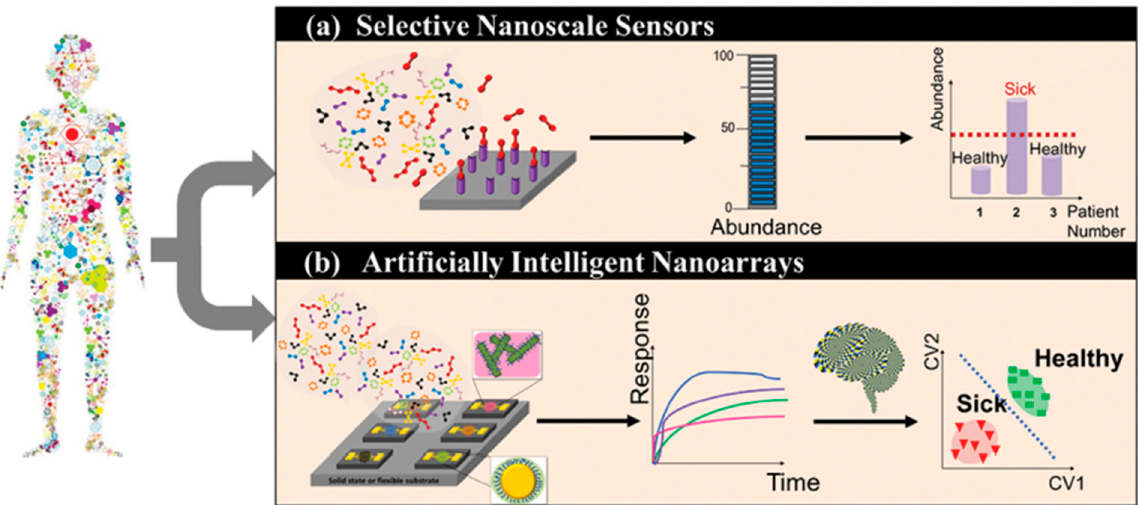
Figure 2. Schematic representation of the working principle of selective sensors and artificially intelligent cross-reactive sensor arrays. Selective sensors contain highly selective elements in order to detect a specific gas-analyte in the presence of a composite gas-mixture. Cross-reactive arrays feature sensors that are sensitive to the majority of the gases present in the gas-mixture. In any case, detecting analyte concentration above a critical value leads to the differentiation between sick and healthy subjects. The response of gas-sensing arrays can be then processed by employing artificial intelligence, machine-learning, and pattern recognition techniques. Reprinted with permission from Ref. [6] Copyright © 2015 Wiley-VCH Verlag GmbH & Co. KGaA, Weinheim.